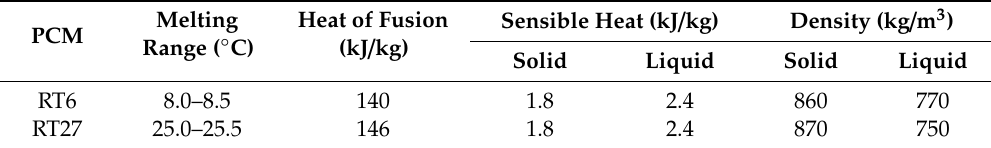
Table 1. PCM thermal